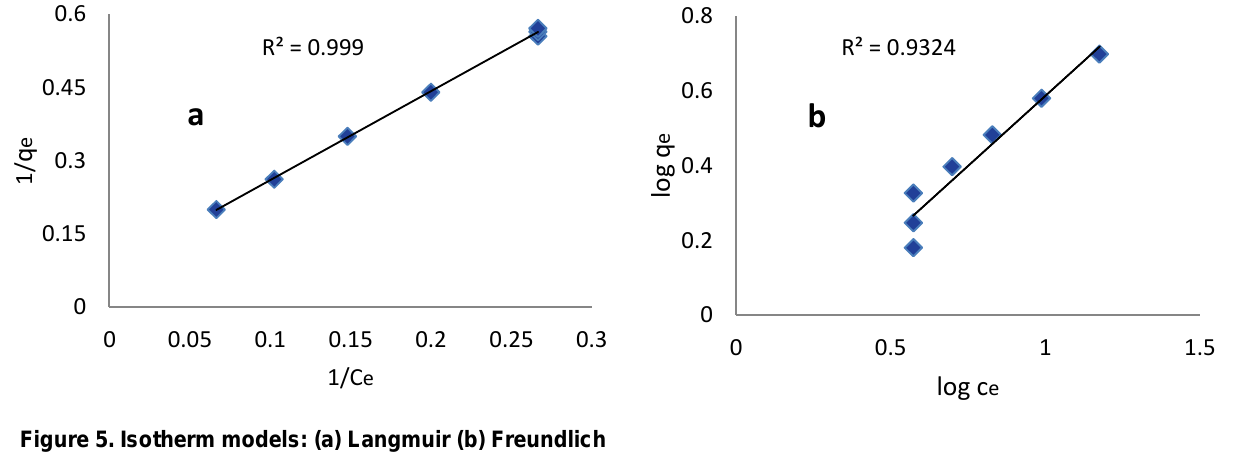
Figure 5. Isotherm models: (a) Langmuir (b) Freundlich